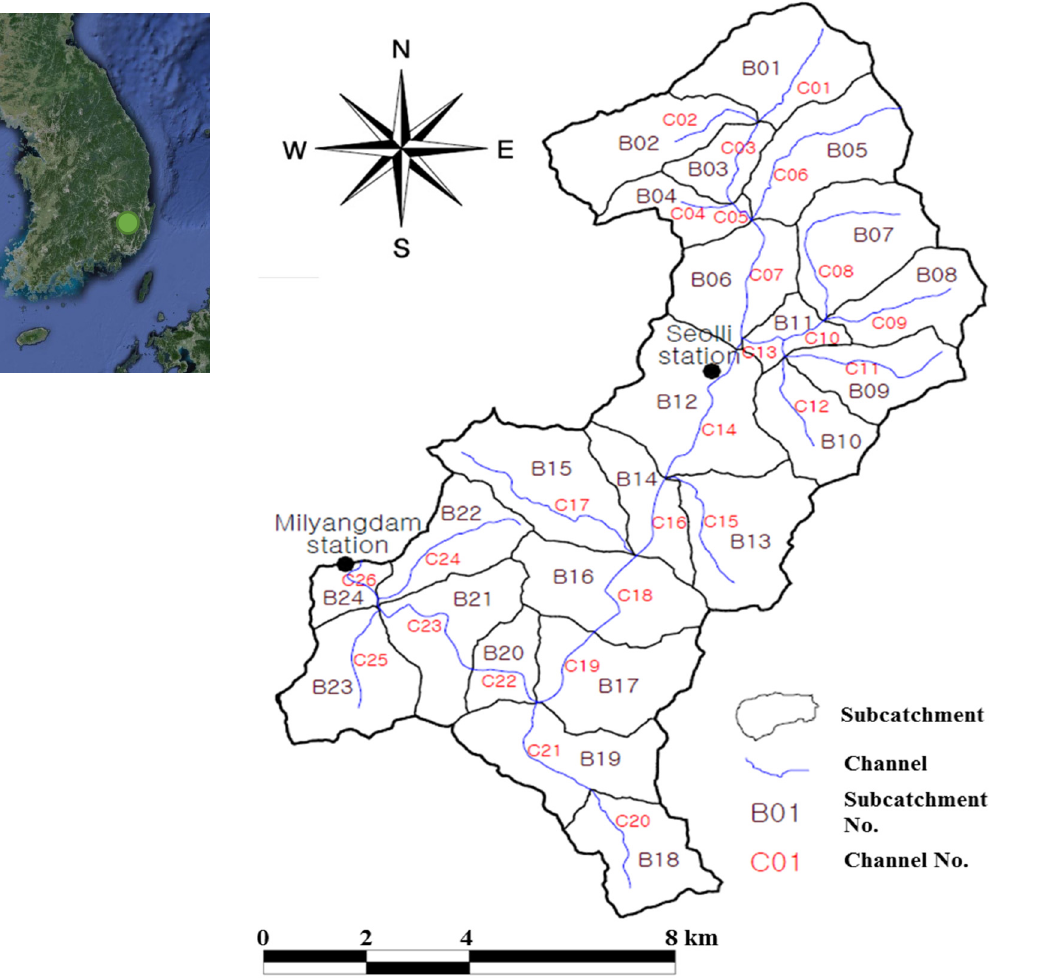
Figure 2. Study area of Milyang Dam